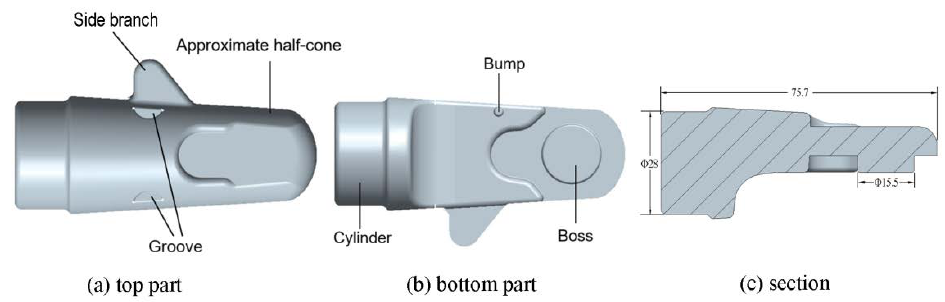
Figure 2. 3D solid model of forging for aluminum alloy component with complex shape: ( a ) top part, ( b ) bottom part, and ( c ) main dimensions.